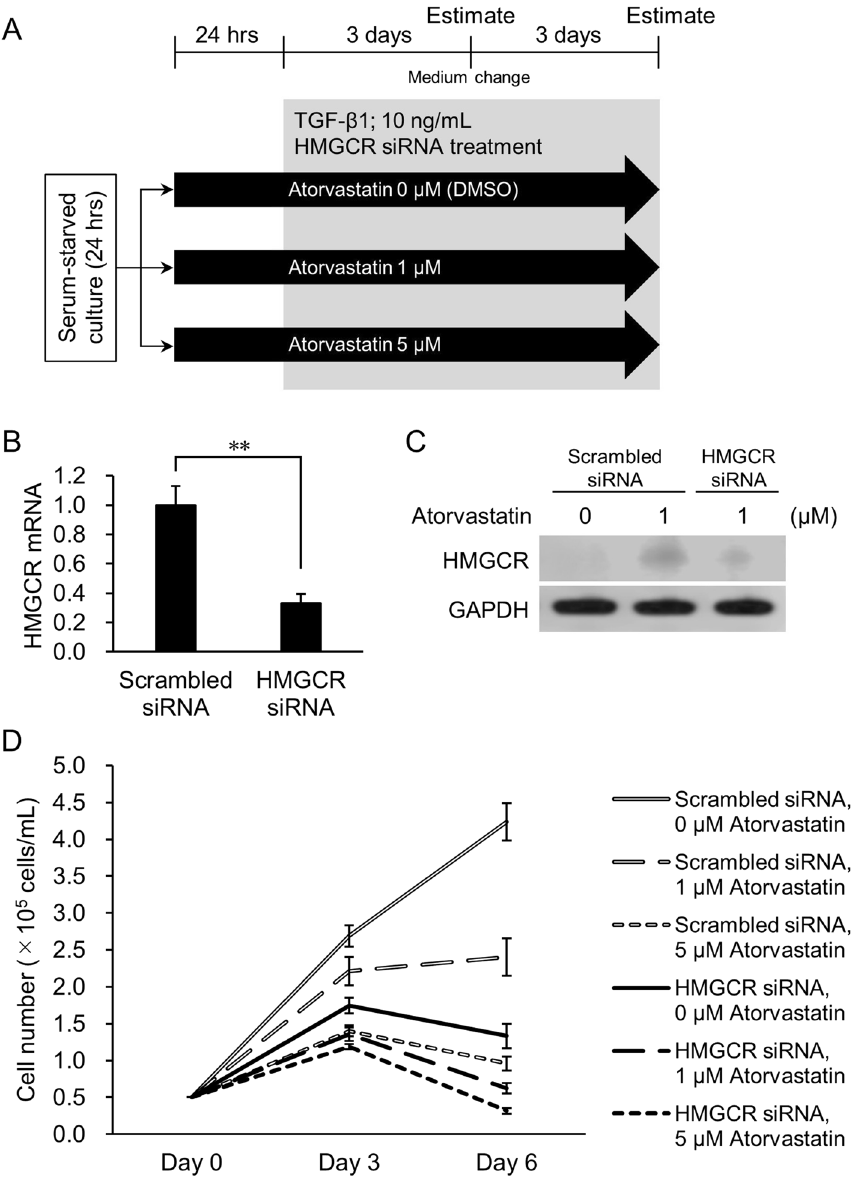
Figure 5. Effect of HMGCR knockdown on atorvastatin-pretreated and TGF-β-induced NCI-H322M cells. ( A ) Overview of experimental procedures. Cells were treated with TGF-β1 in the presence of 1 μM or 5 μM atorvastatin and HMGCR siRNA. Scrambled siRNA was used as negative control for RNAi experiment. Cell numbers were counted at days 3 and 6 after TGF-β1 induction. ( B ) Expression of HMGCR mRNA in cells 3 days after transfection of HMGCR siRNA. Data are normalized to 18S rRNA level in each sample and are expressed as values relative to that of the internal control. The measurement values for each group are compared using student’s two-tailed t -test. Mean ± SD, n = 3, ** p < 0.01. ( C ) HMGCR protein levels in cells 3 days after transfection of HMGCR siRNA. Panel indicates western blot analysis of HMGCR after siRNA transfection in cells. ( D ) Cell number of the TGF-β1 (+) group treated with 0–5 μM atorvastatin and HMGCR siRNA at days 3 and 6. Each value represents mean ± SD (n = 3). Statistical analysis is shown in Supplementary Table